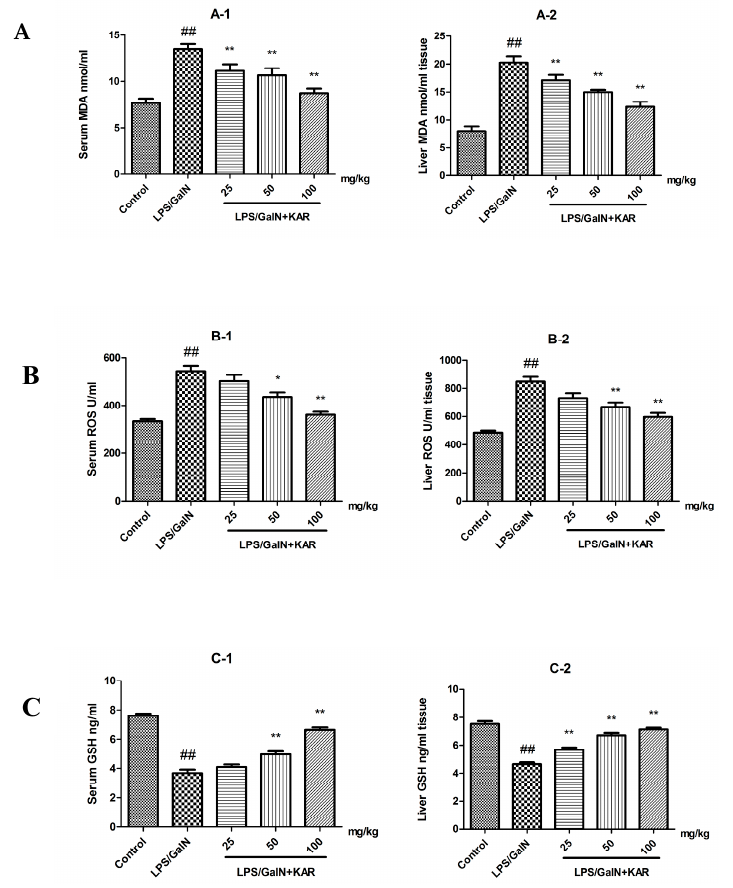
Figure 3. The levels of the MDA, ROS, and GSH ( A – C ) in serum and liver tissues were measured using an ELISA assay. The data represented show the mean ± SD ( n = 15). * p < 0.05, ** p < 0.01 compared to the FHF model group, and ## p < 0.01 compared to the control group.